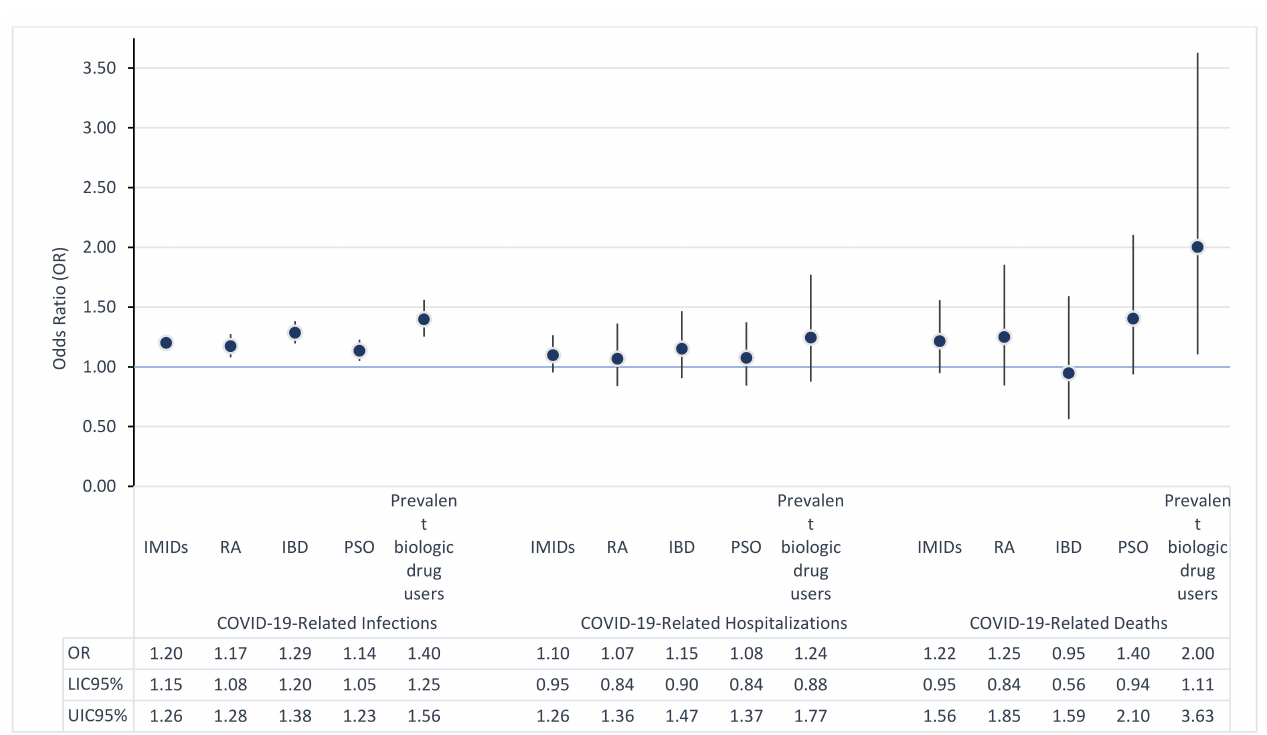
Figure 1. Risks of infection, hospitalization and mortality COVID-19 related in patients affected by IMIDs. Note.